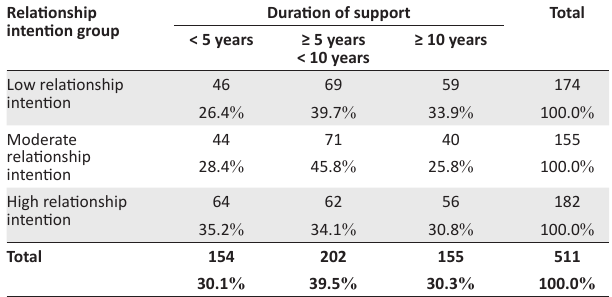
TABLE 7: Cross-tabulation between relationship intention groups and duration of